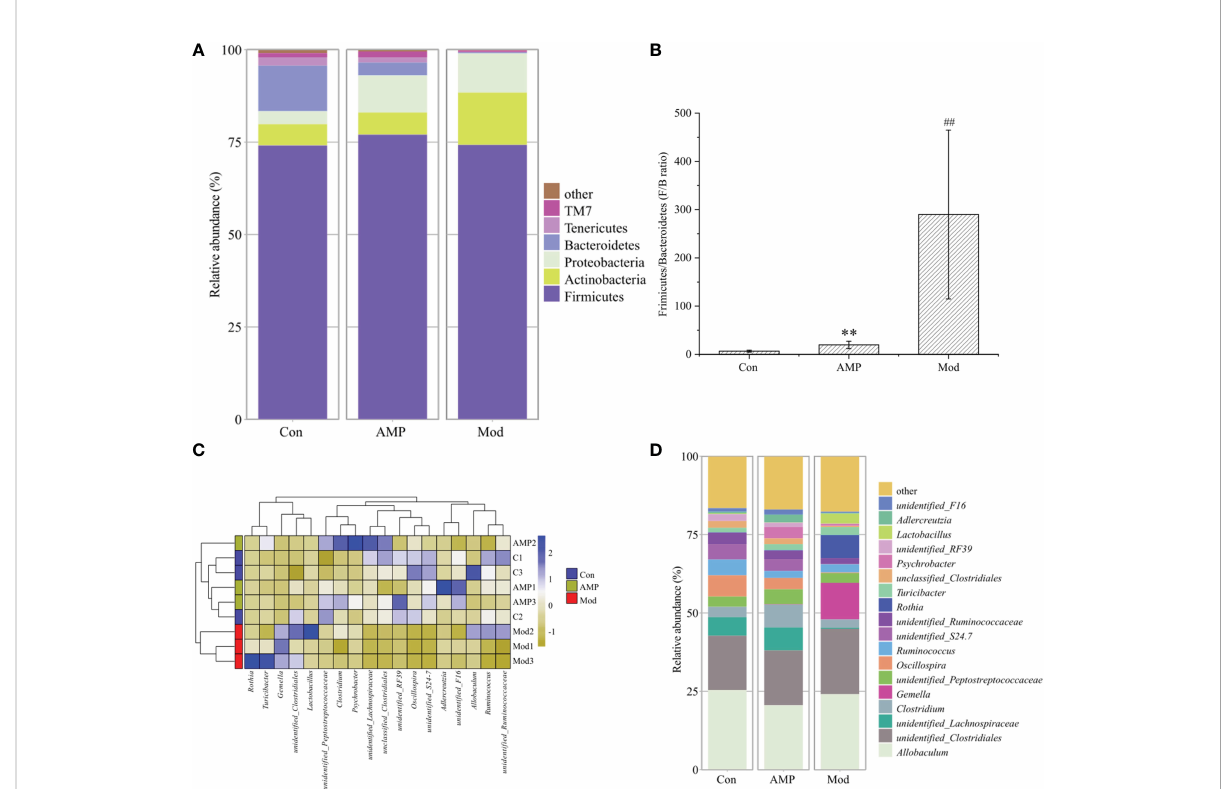
FIGURE 6 Effect of AMP on the relative abundance of intestinal microbiota in MGH rats (relative abundance (A) , phyla level; (B) , Firmicutes/Bacteroides; thermogram of relative abundance at (C) , phyla level; relative abundance at (D) , genus level). Compared with Con group, # represents P < 0.05, ## represents P < 0.01; Compared with Mod group, * represents P < 0.05, ** represents P <